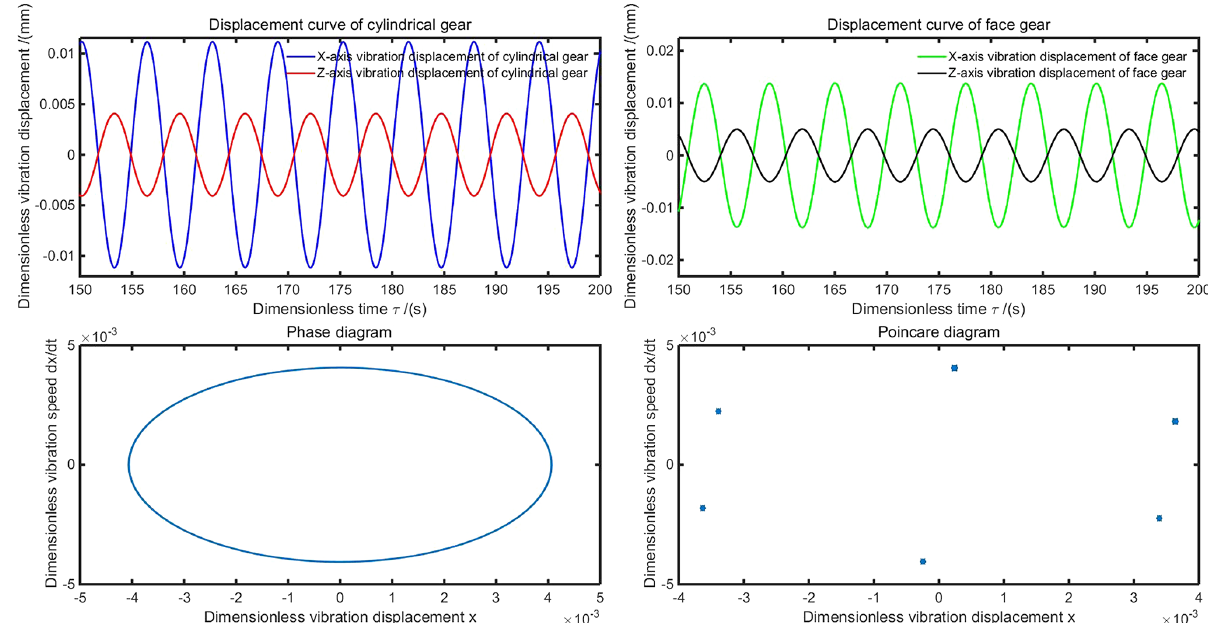
Figure 4. Displacement, phase, and Poincare diagrams of 1st stage face gear